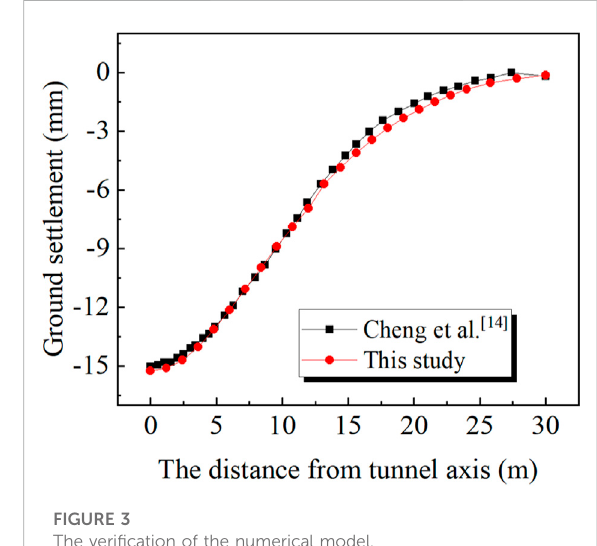
FIGURE 3 The veri fi cation of the numerical